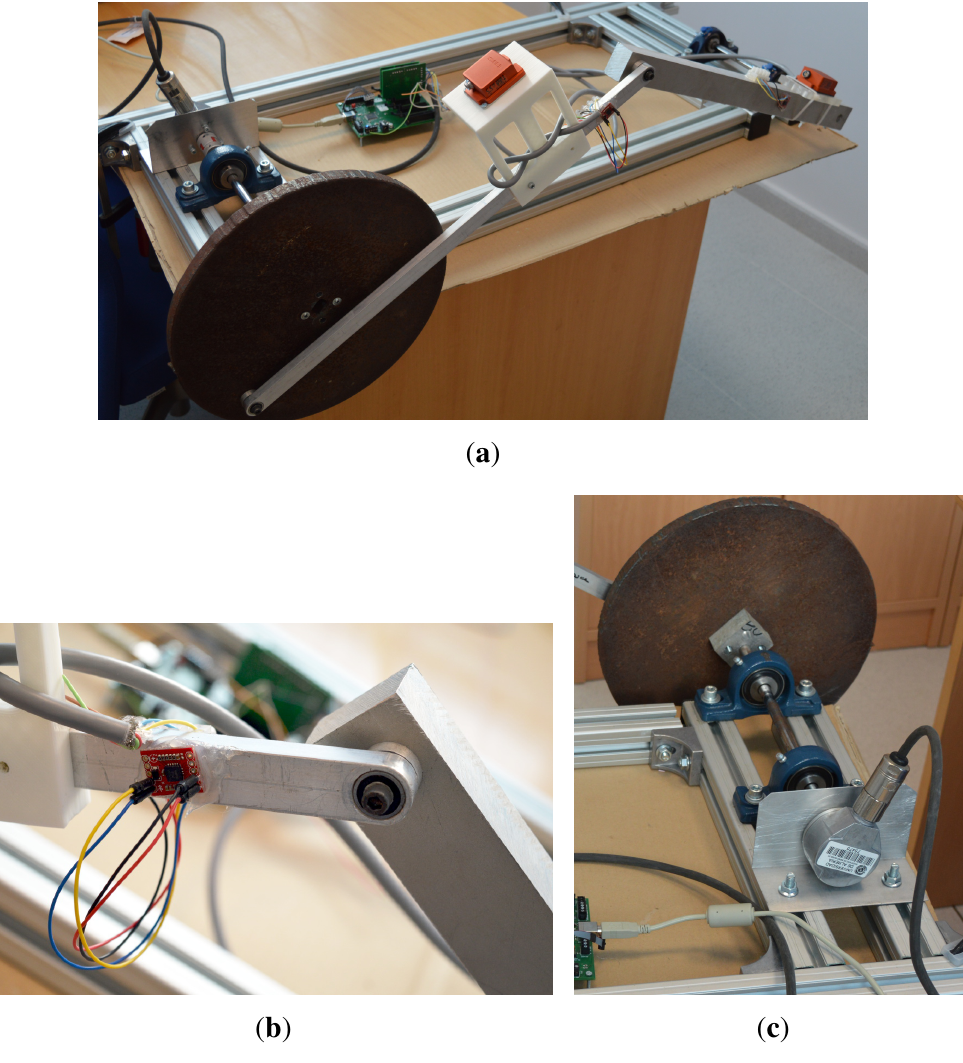
Figure 6. ( a ) Four-bar mechanism testbed; ( b ) Detail of the gyroscope mounted in the connecting rod; ( c ) Detail of the crank and optical quadrature encoder